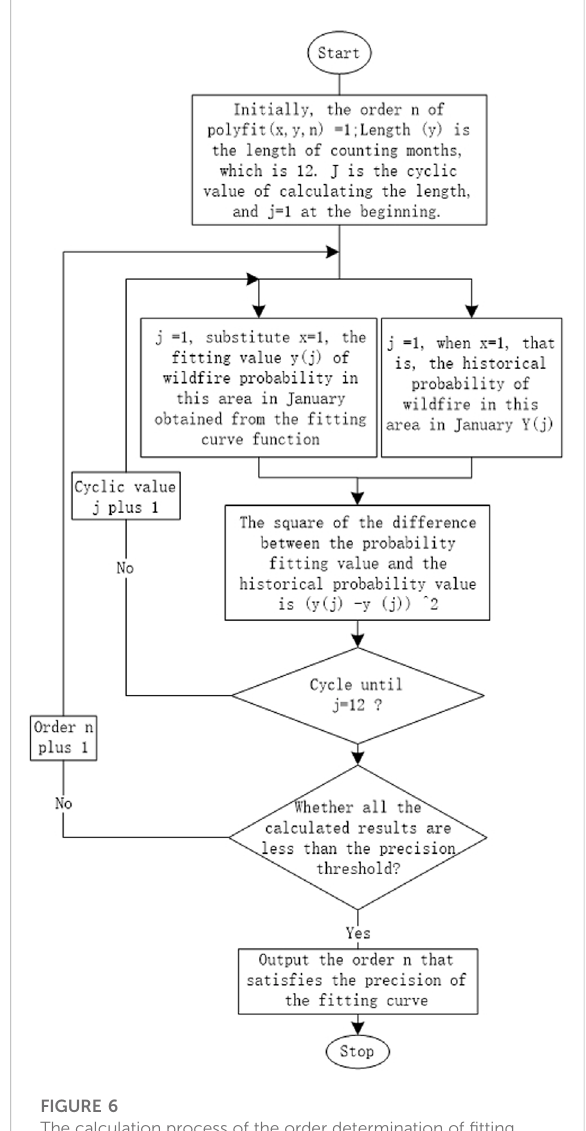
FIGURE 6 The calculation process of the order determination of fi tting curve